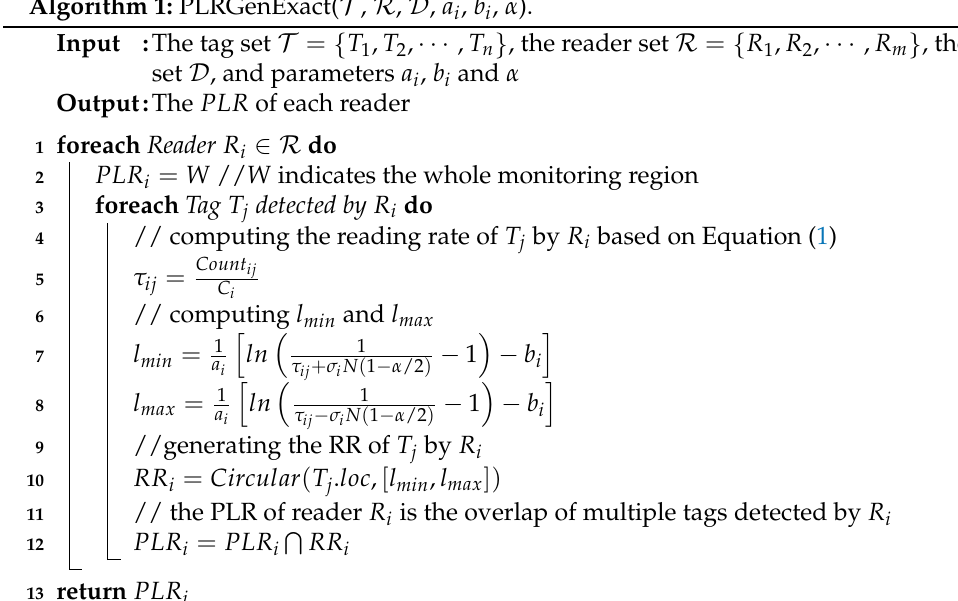
Algorithm 1: PLRGenExact( T , R , D , a i , b i , α